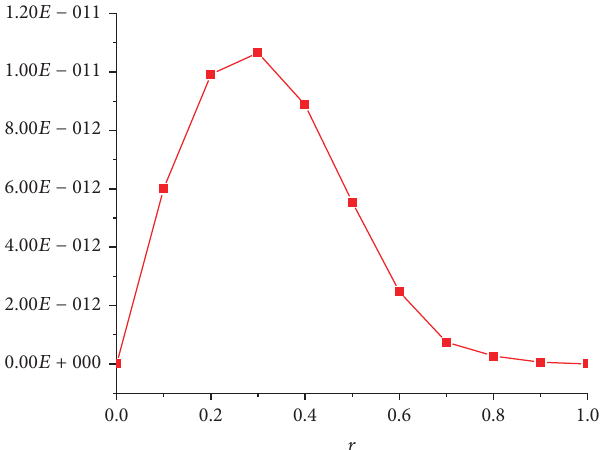
Figure3:Errorgraph(showingconvergenceofOHAM):OHAMup to second-order solution when 𝑈 = 0.2 , 𝛽 1 = 0.3 , 𝛽 2 = 1 , 𝜆 = 0.3 , and 𝛿 = 2 .